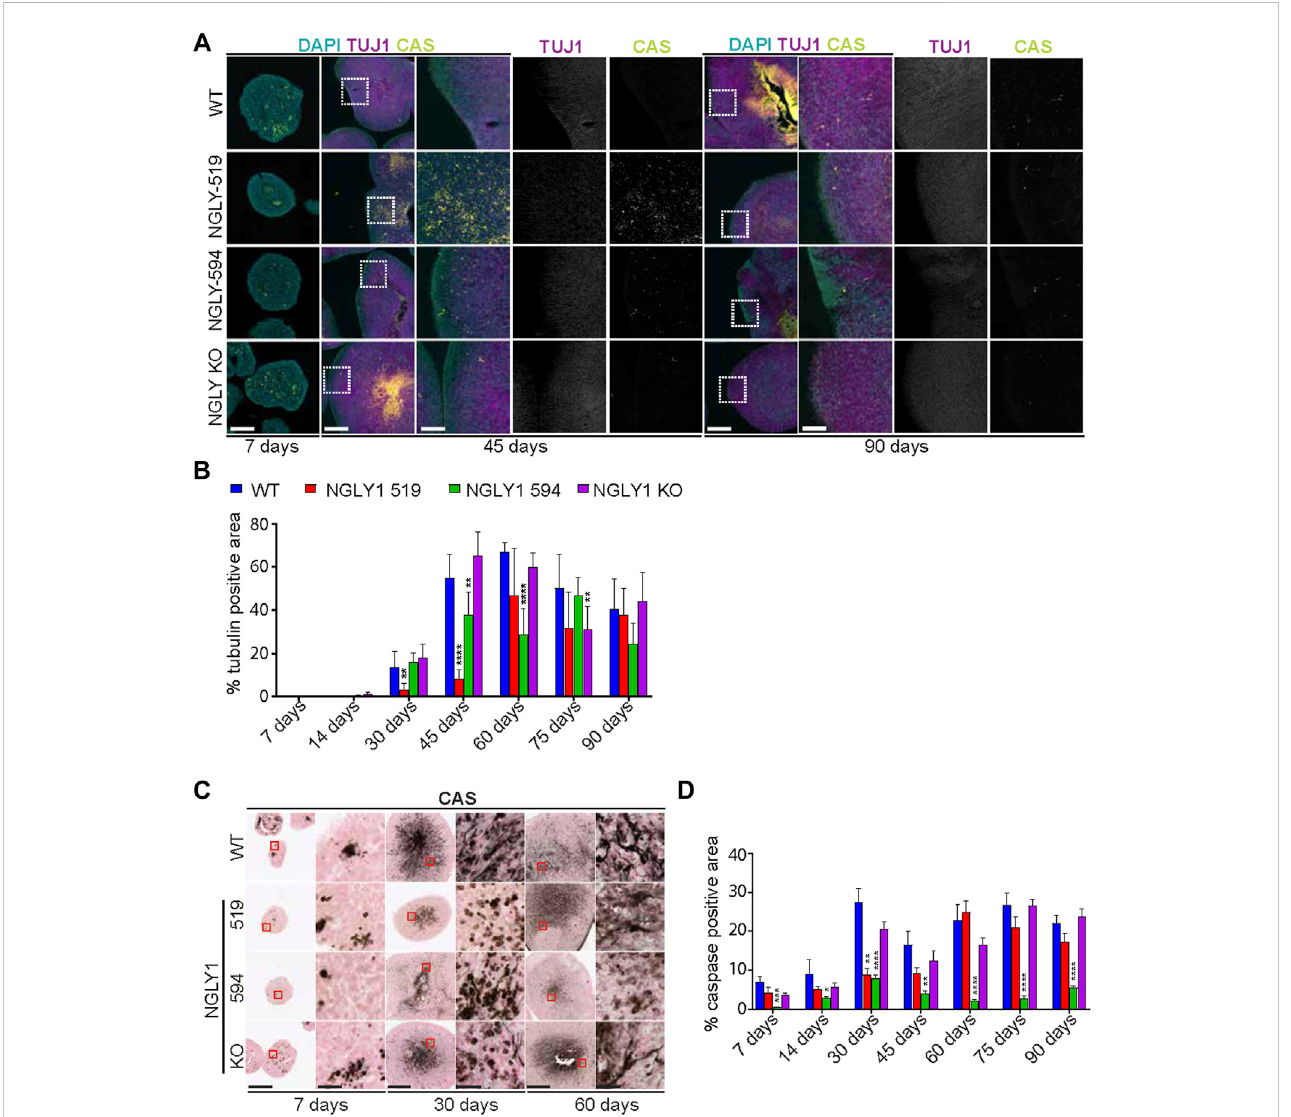
FIGURE 2 Development and health of organoids as determined by β III Tubulin (TUJ1) and Caspase3 (CAS) staining in wild type (WT), mutant (NGLY1-519 and NGLY1-594) and knockout (NGLY1 KO) midbrain organoids. (A) Immuno fl uorescence images at ×5 and ×20 magni fi cation showing DAPI (cyan), TUJ1 (magenta) and CAS (yellow) staining in each line. At 30 days the mutant and KO lines develop a distinct TUJ1 staining pattern relative to the WT, with signi fi cantly less density at the edge of the organoid. Scale bars: 125 μ m (5x), 25 μ m (20x). White dashed line boxes indicate regions of magni fi cation. (B) Quanti fi cationofthetotalTUJ1-positive areaineachline ateach timepoint. Bar graphshows thepercentofthetotaltissue areaofeachline thatwaspositive for TUJ1. Time points where the percentage of TUJ1-positive area in WT organoids was close to zero were excluded. (C) Immunohistochemistry images at×4and×40magni fi cationshowingCASstainingineachorganoidline.Asorganoidsgrowinsize,regionsofintenseCASstainingdevelopatthecenterofthe wildtypeandmutantlines.Scalebars:250 μ m(4x),25 μ m(40x).Redboxesindicateregionsofmagni fi cation. (D) Quanti fi cationofthetotalCAS-positivearea in each line at each time point. Bar graph shows the percent of the total tissue area of each line that was positive for CAS. Data representative of all slices derivedfromthreemidbrainorganoids.Statisticalsigni fi cancedeterminedbymultiple t -testanalysisdenotedby*=( p ≤ 0.05),**=( p ≤ 0.01),***=( p ≤ 0.001), **** = ( p ≤